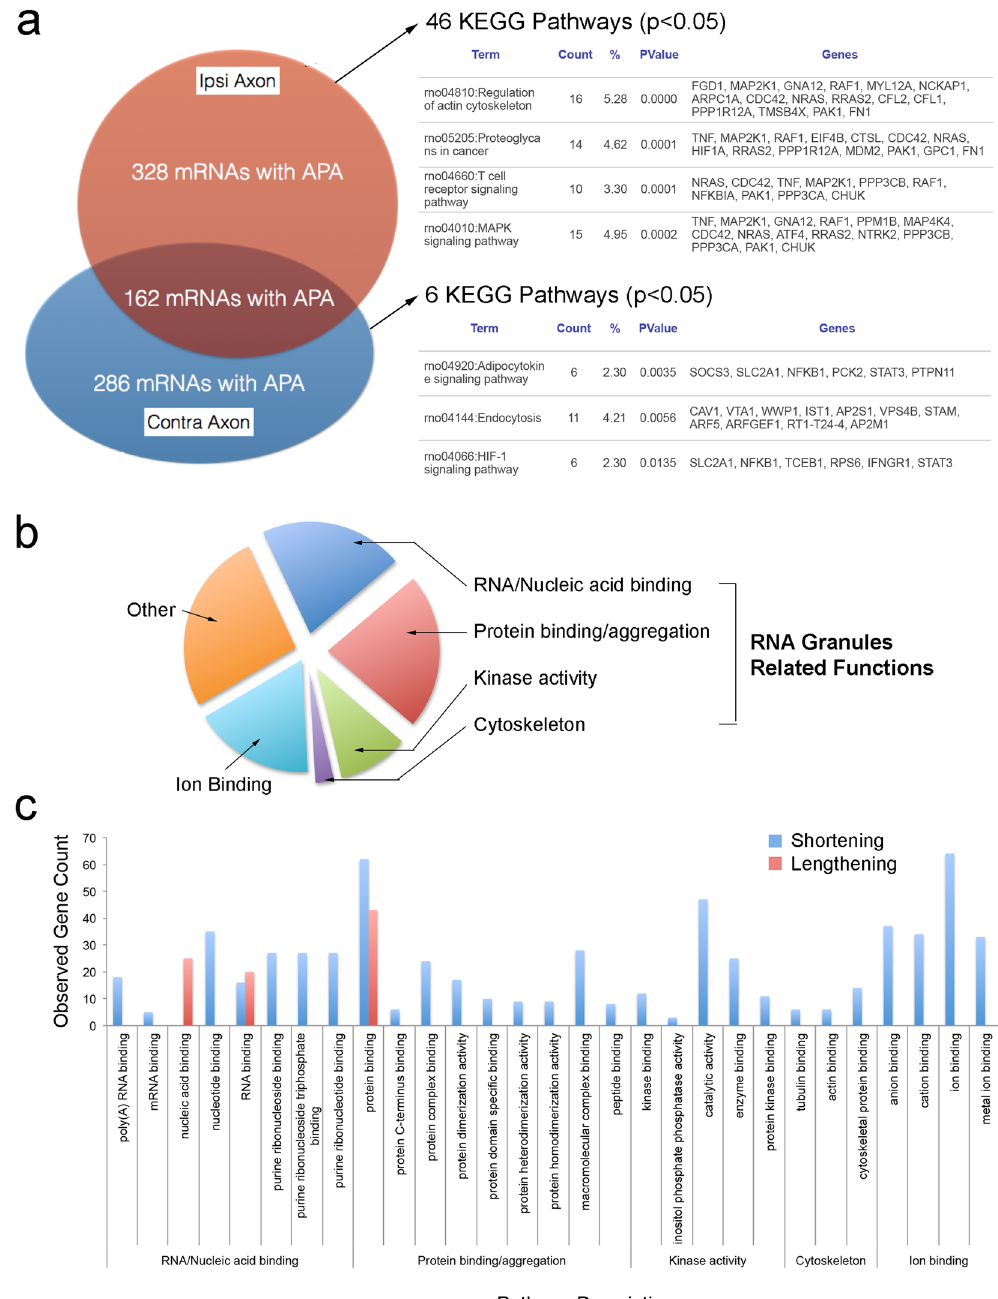
Figure 5. KEGG and Gene ontogeny (GO) pathways of mRNA species containing different 3 ′ UTRs in axons. ( a ) The normalized read coverage in DaPars analysis (p < 0.05) suggested 490 and 448 mRNAs with the use of alternative 3 ′ UTRs in ipsi- and contralateral axons, respectively. Of these mRNAs, 162 species existed in both ipsi- and contralateral axons. Those mRNAs specific to SNE-conditioned and control axons showed strong alliance to 46 and 6 KEGG pathways at the significance level p < 0.05, respectively. ( b ) GO function analysis of mRNAs with alternative 3 ′ UTRs in the SNE-conditioned ipsi axons showed strong clustering in functional pathways, which included RNA binding, protein binding and aggregation, kinase activity, and cytoskeletal molecule binding. These functions appeared to be related to stress granule formation. ( c ) The majority of mRNAs clustered in the stress granule related pathways contained shortened 3 ′